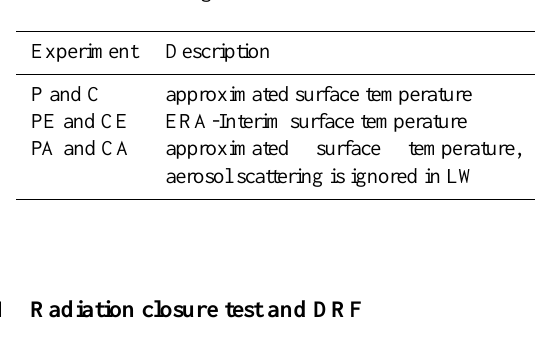
Table 2. Spectral ranges of the satellite products, ground observa- tions and RRTM model. Wavelengths are given in